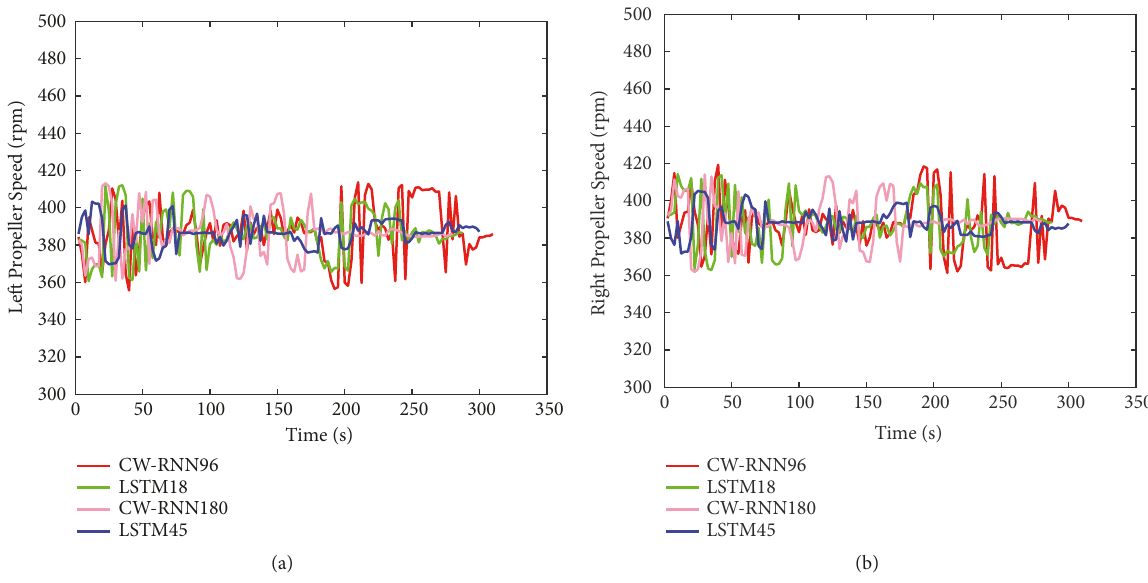
Figure 12: Curves of propeller speed controlling feedback corresponding with the different obstacle avoidance